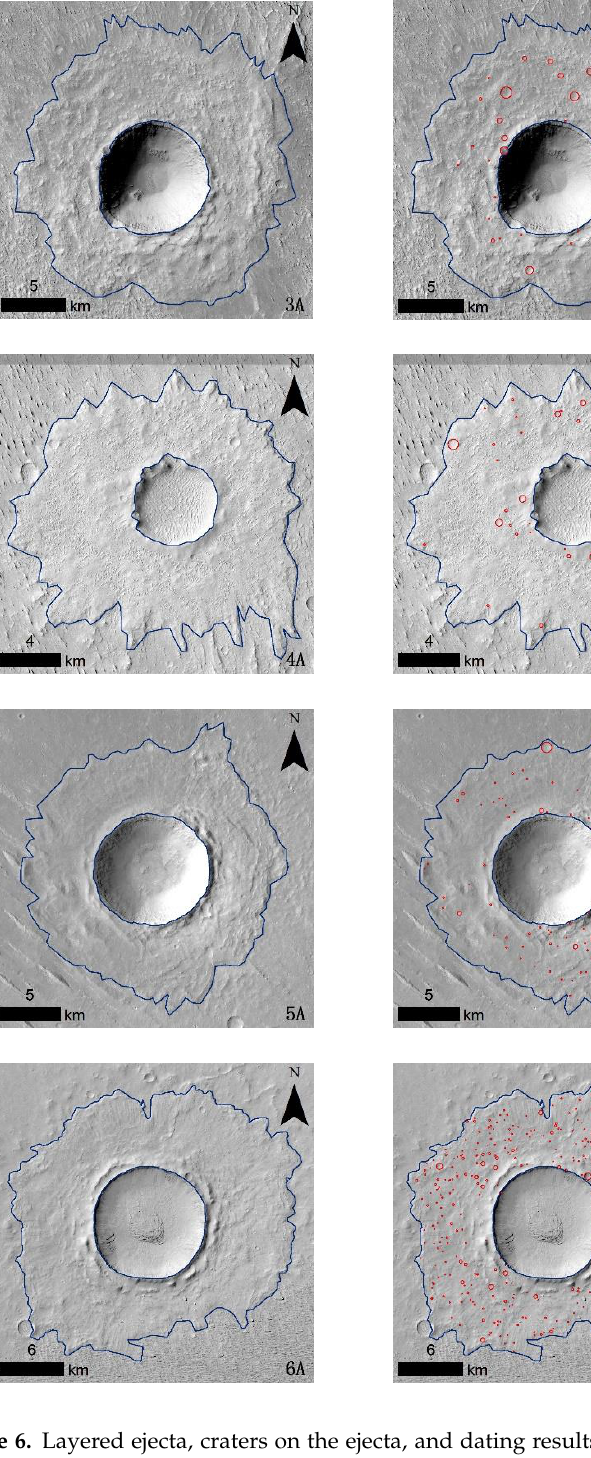
Figure 6. Layered ejecta, craters on the ejecta, and dating results in the MFF. There are six layered ejecta selected after rigorous evaluation that are definitely formed after the development of corresponding yardangs had been ceased. Layered ejecta labeled from 1A to 6A are the primary image, and 1B to 6B are corresponding to the layered ejecta in Figures 3 and 4, respectively. Central location: (1) 148.18°E; 2.22°N., (2) 148.33°E; 0.43°N., (3) 148.58°E; 0.68°S., (4) 149.94°E; 0.09°S., (5) 142.30°E; 2.03°N., (6) 152.11°E; 3.26°N. The Martian chronology system is Neukum – Ivanov (2001; see [18,29,53]), and the production function is from Ivanov (2001).